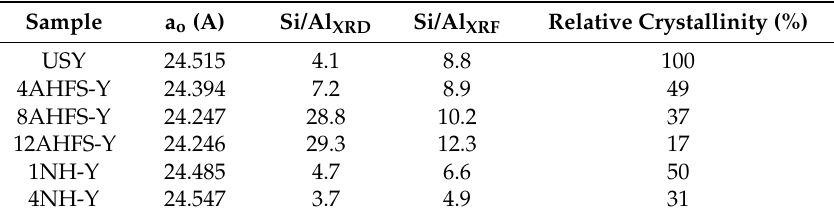
Table 1. Crystal structure parameters of modified USY.